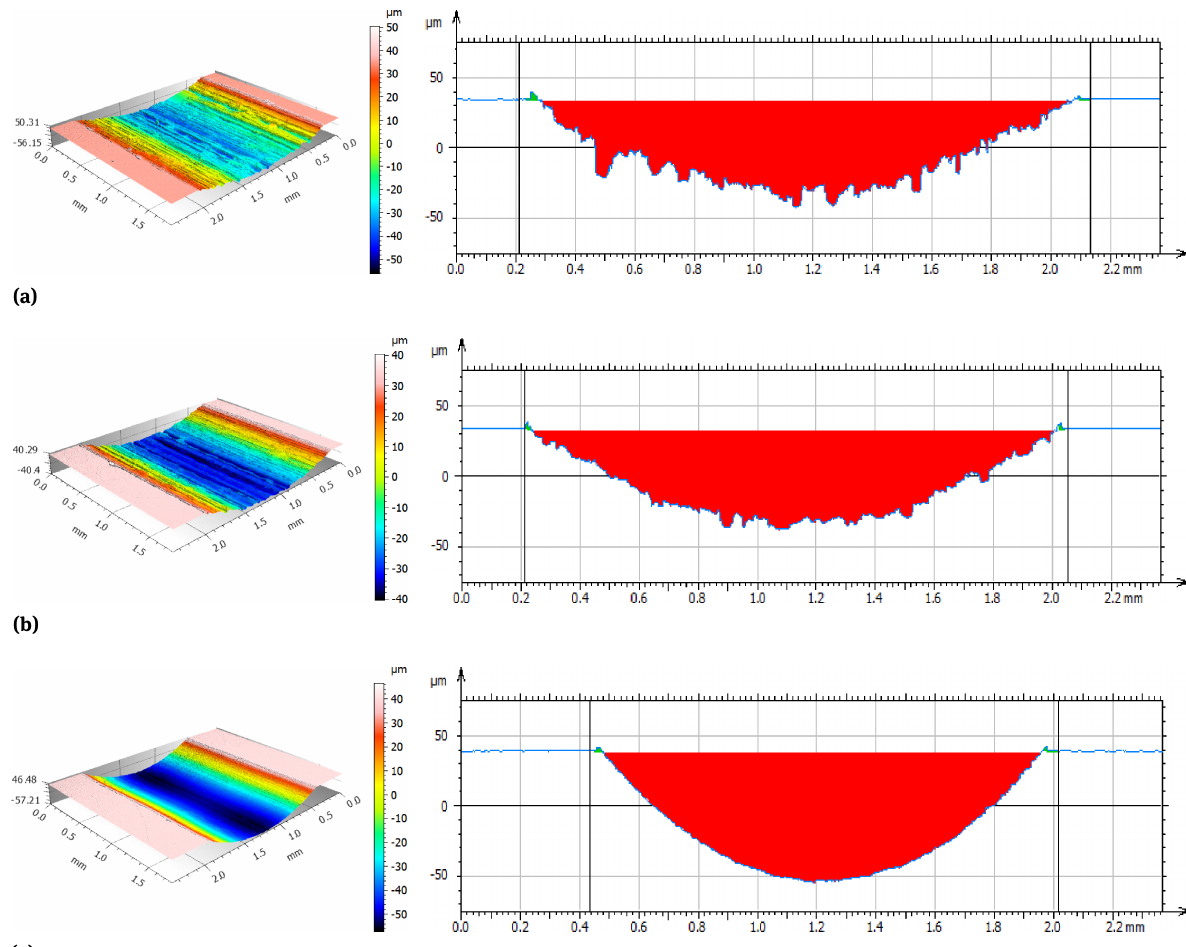
Figure 14: The isometric image of the trace of wear and the wear profile in a cross-section for Ti13Nb13Zr a) TDF, b) RS, c)